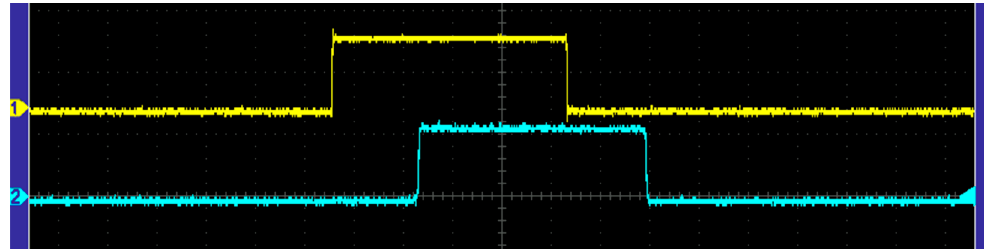
Figure 7. Diagram showing signal delay between input (Channel 1) and output (Channel 2).